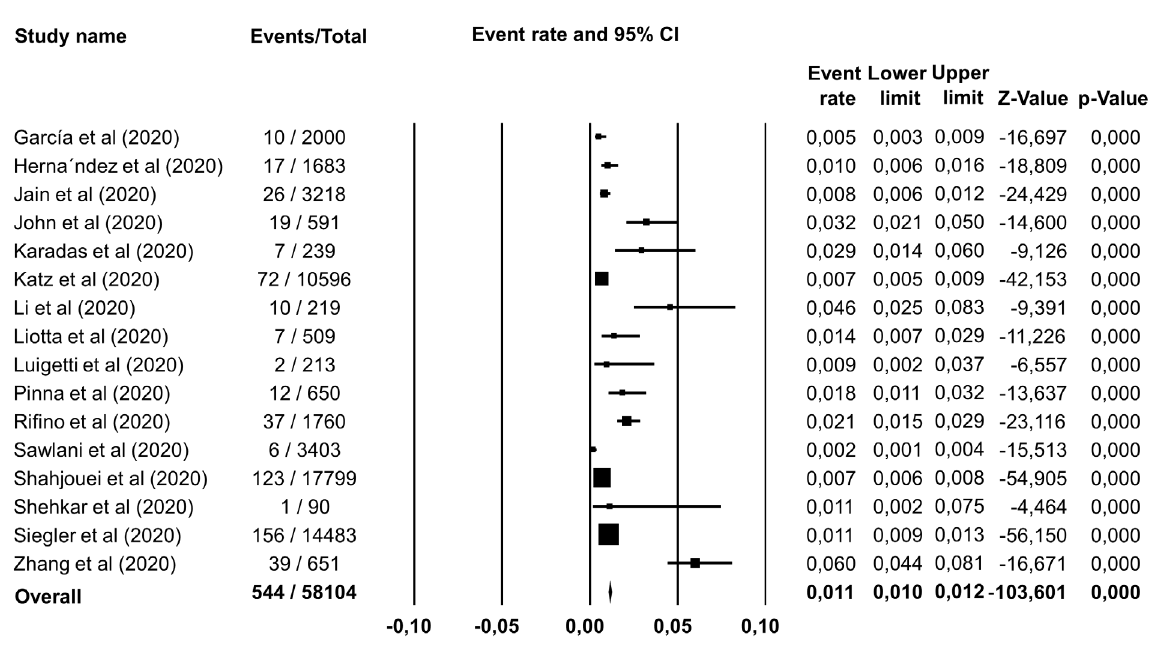
Figure 3. Forest plot of the prevalence of ischemic stroke in COVID-19 patients. The pooled estimate of ischemic stroke prevalence is 1.11% with 95% CI 1.03%–1.22%, p<0.0001; p-value for Egger and heterogeneity is 0.730 and <0.0001, respectively with I 2 94.07%.